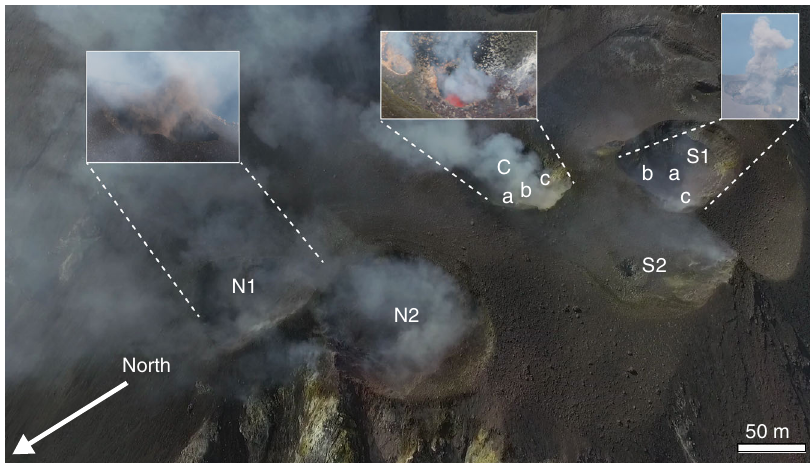
Fig. 1 Stromboli volcano summit area. Multi-vent structure of the crater terrace of Stromboli, imaged during a UAS over fl ight on 6 June 2018. Indicated are main degassing areas (N Northern, C Central and S Southern) with numbers indicating separate vents. In response to the distinct eruptive behaviour and degassing characteristics observed, we retain these as separate vent areas rather than adopt the dual characterisation (N and SW + C) previously proposed. Lowercase letters indicate the location of individual intracrater vents where more than one is present. Inset are images of explosions from vents N1 and S1 a , and incandescence and passive degassing within C b